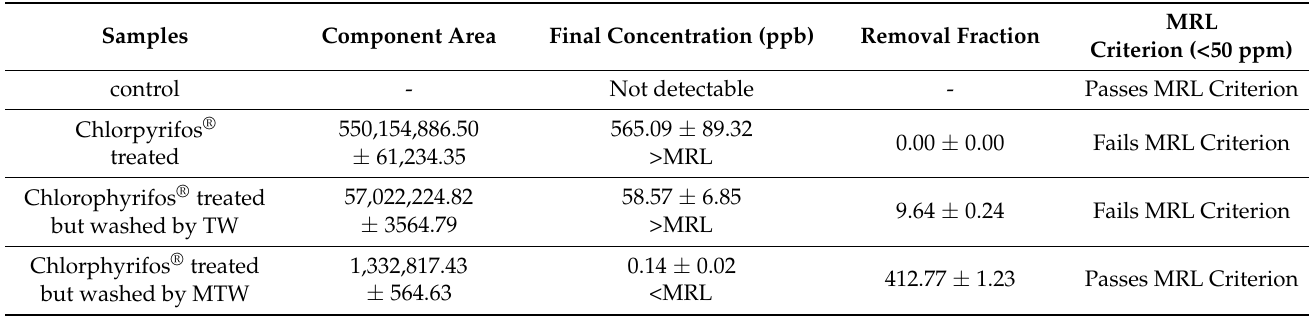
Table 3. Comparison of component retention time (RT), component area and percent match factor of extracted samples washed by TW and MTW comparing to control (no pesticide contamination). Values quoted are means ± standard errors, n = 3. The Maximum Residue Load (MRL) value for Chlorpyrifos ® is 50 ppb [10,33,34]. Conclusions drawn in columns headed Final Concentration, Removal fraction and Pass/Fail MRL are based on ANOVA and Student–Newmann–Kuels test criterion ( p <